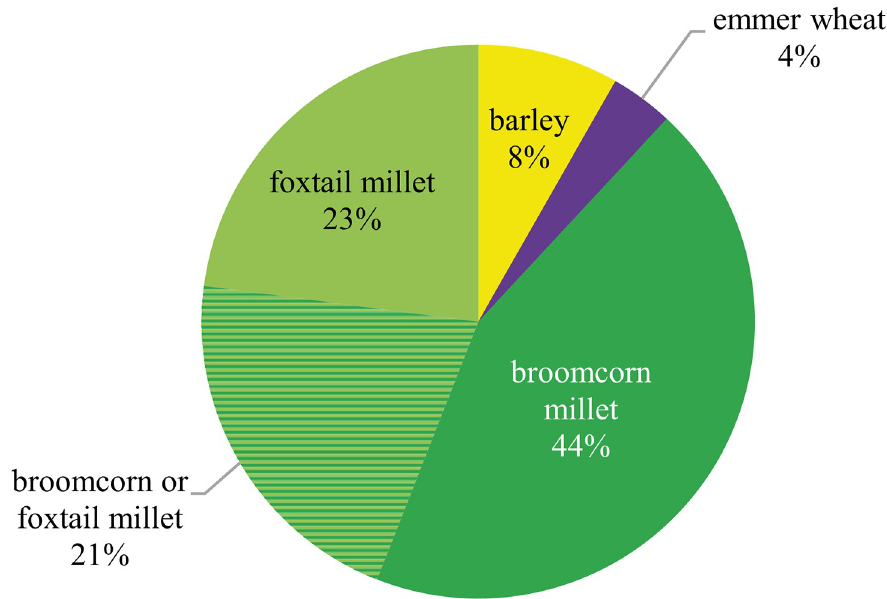
Fig 13. Simplified spectrum of cereal grain finds at Late Bronze Age Prigglitz-Gasteil, following Stika & Heiss [177, 178] as laid out in section 2.3.4. n = 101. Diagram: OeAW-OeAI/T. Jakobitsch.